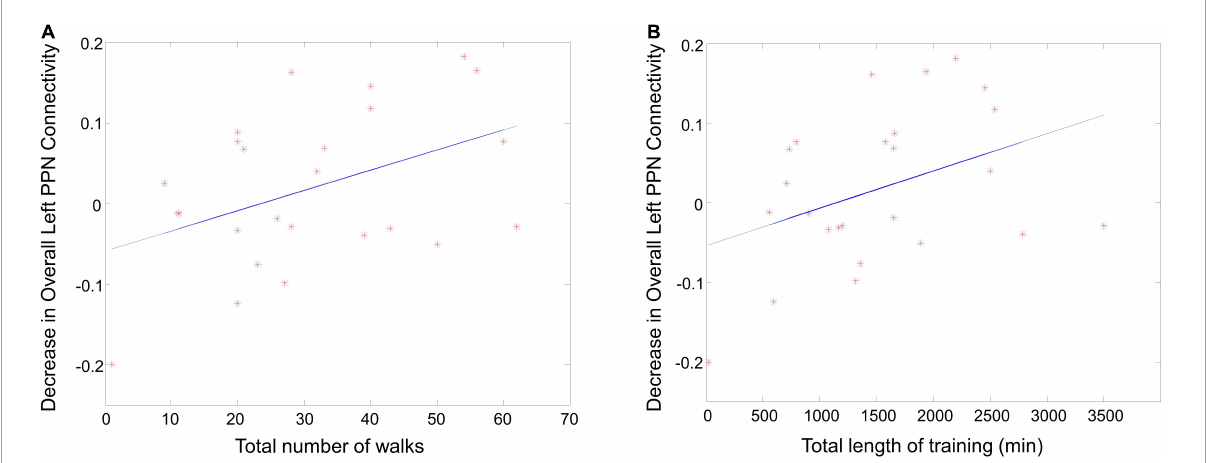
FIGURE7 The correlation between PPN functional connectivity and walking metrics. (A) The correlation between the decrease in overall left PPN functional connectivity and the total number of walks. (B) The correlation between the decrease in overall left PPN functional connectivity and the total length of